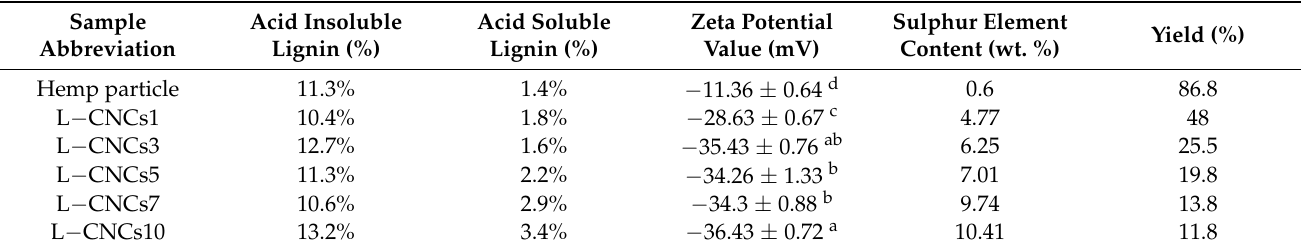
Table 1. The content of lignin (%), zeta potential and sulphur element of